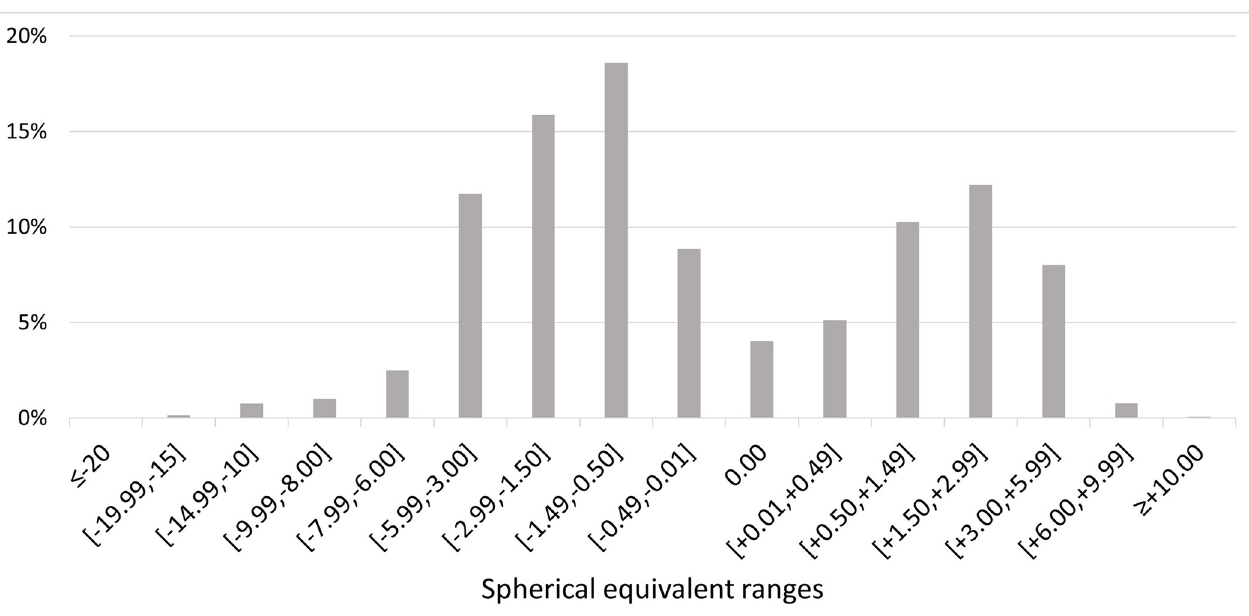
Fig 4. Distribution of ophthalmic prescriptions in Portugal in 2020 according to single vision ophthalmic lenses prescriptions. Dashed line shows average fitting to data.